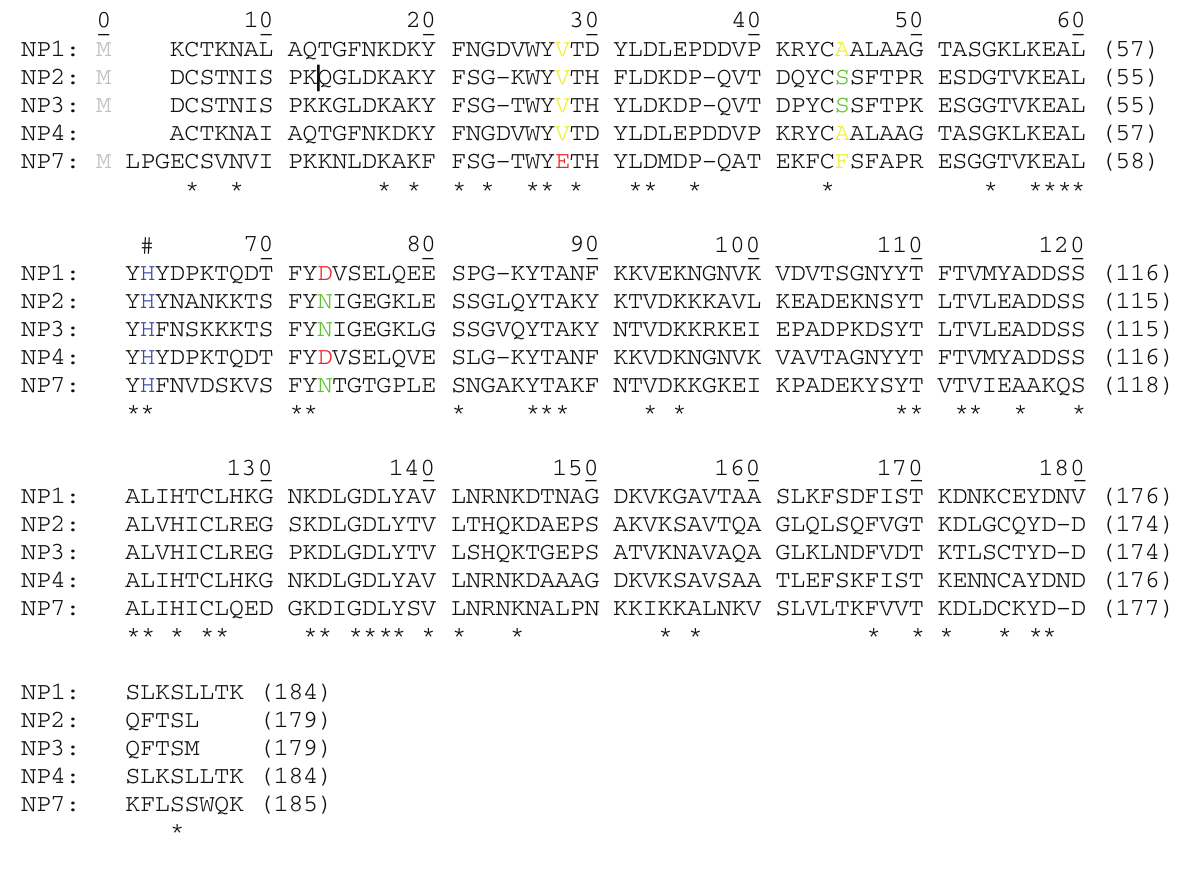
Figure S3. Amino acid sequence alignment of R. prolixus NP1 (Swiss-Port entry Q26239), NP2 (Swiss-Port entry Q26241), NP3 (Swiss-Port entry Q94733), NP4 (Swiss-Port entry Q94734), and NP7 (Swiss-Prot entry Q6PQK2) (1) . The total sequence identity among all five protein sequences amount to 33% (indicated by ‘ * ’). The proximal His is indicated by ‘#’. An initial Met residue (in grey) results in case of the recombinantly expressed proteins of NP1, NP2, NP3, and NP7 is not present in the mature proteins in vivo ( 2, 3 ). Residues of relevance to this study are highlighted in